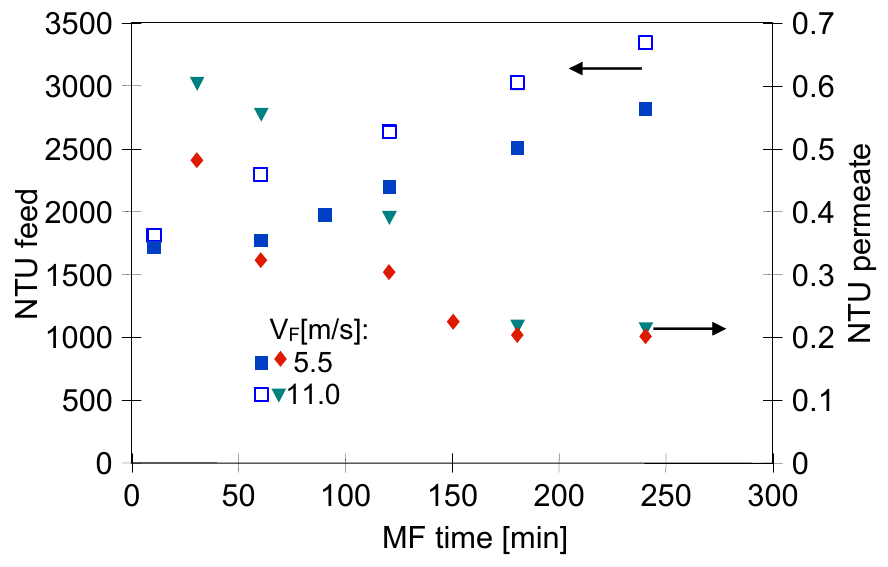
Figure 8. Changes in feed and permeate turbidity during MF of 1,3-PD fermentation broth with Citrobacter freundii . Module M4, TMP = 0.08